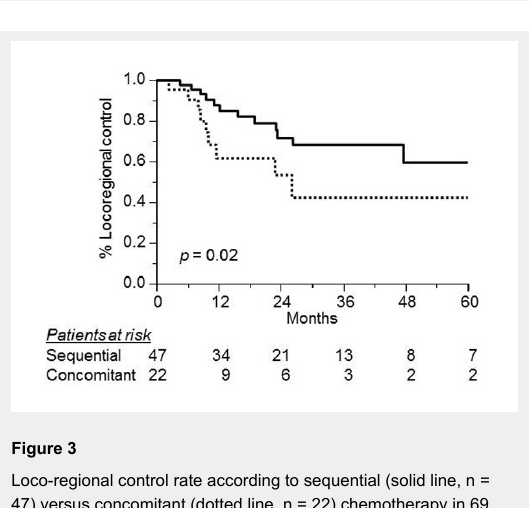
Loco-regional control rate according to sequential (solid line, n = 47) versus concomitant (dotted line, n = 22) chemotherapy in 69 patients with limited stage small-cell lung cancer (log rank test, p =